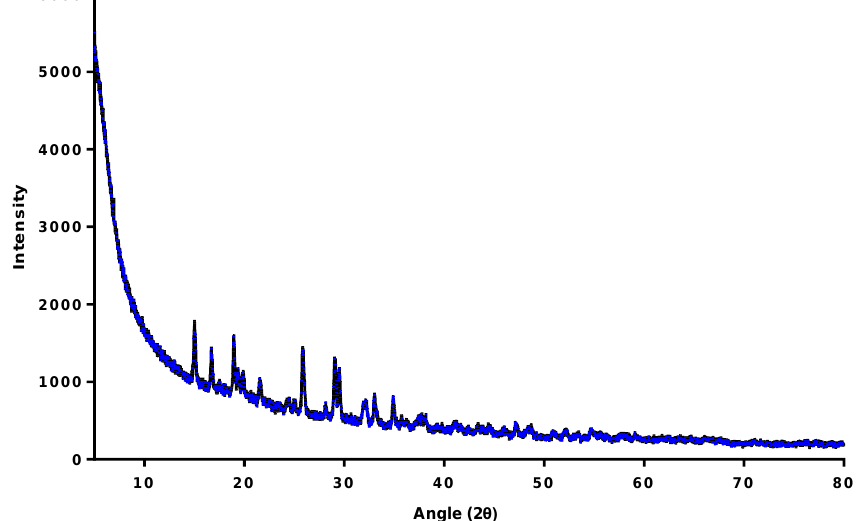
Figure 4. X-ray diffraction of the purified bioflocculant.